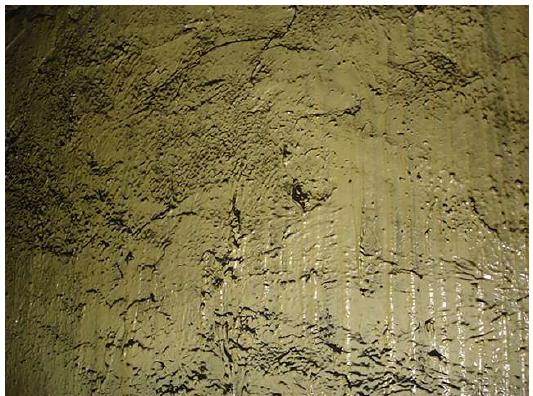
Figure 17. Practical application of modified polyurethane elastomer (PUE) in a coal mine [70].